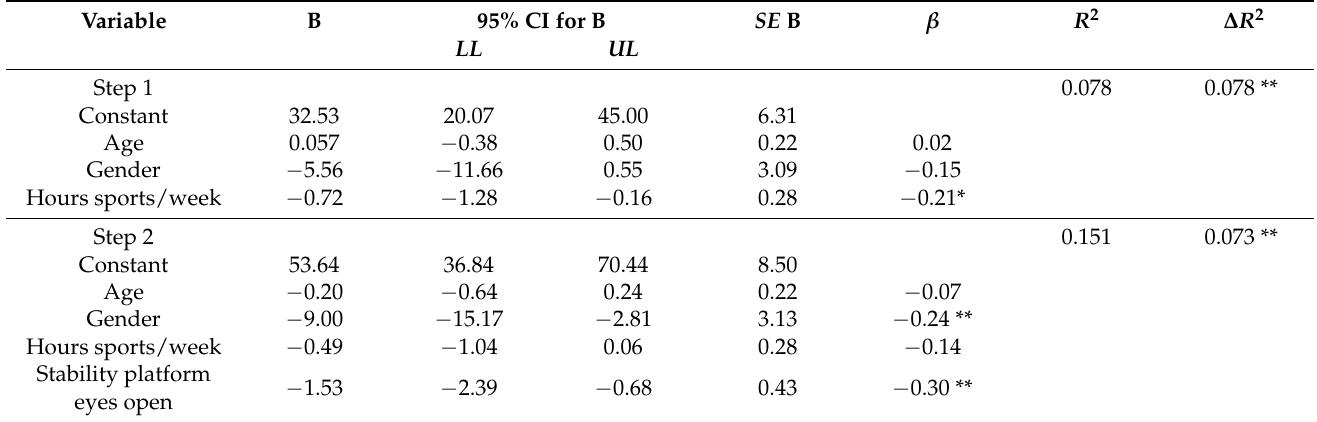
Table 2. Hierarchical regression model for perspective-taking abilities (OPT task).